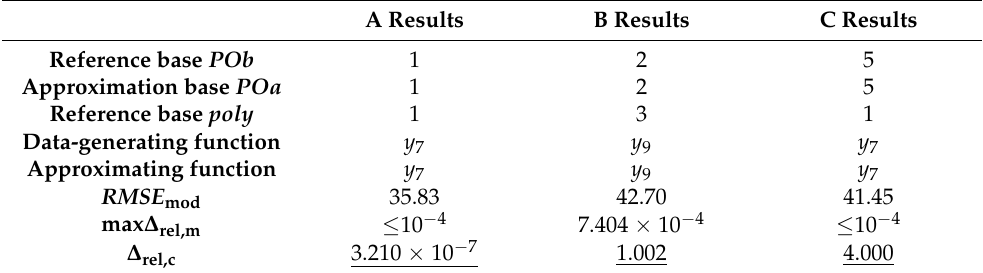
Table 5. Exemplary results obtained using the adopted criterion (the most important differences are